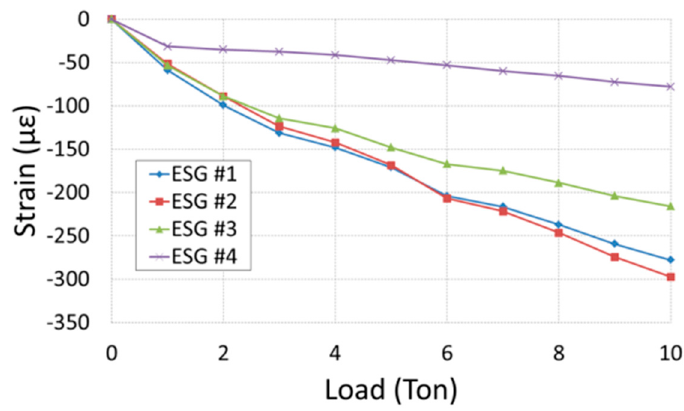
Figure 9 . Strains from four strain gauges bonded on the bearing plate installed with 0 degrees with varying loads.